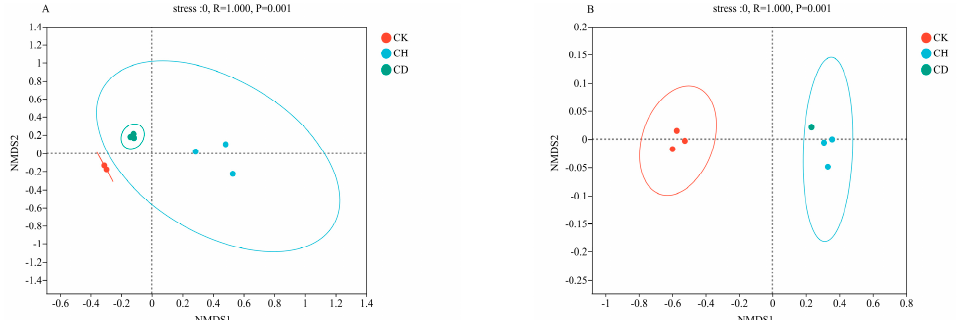
13 of 22 Figure 8. ( A ) PCoA analysis of bacterial community structure. ( B ) PCoA analysis of fungal commu- nity structure. CH—biennial ginseng seedlings that were transplanted and then continuously cropped for four years in healthy ginseng rhizosphere woodland soil, CD—biennial ginseng seed- lings that were transplanted and then continuously cropped for four years with severe soilborne disease in ginseng rhizosphere woodland soil, CK—soil sample from woodland without ginseng planting. Based on the OTU annotation results, the bacterial communities and fungal commu- nities of the three samples were analyzed by nonmetric multidimensional scaling (NMDS) using the Bray ‒ Curtis distance algorithm. The differences in bacterial and fungal commu-